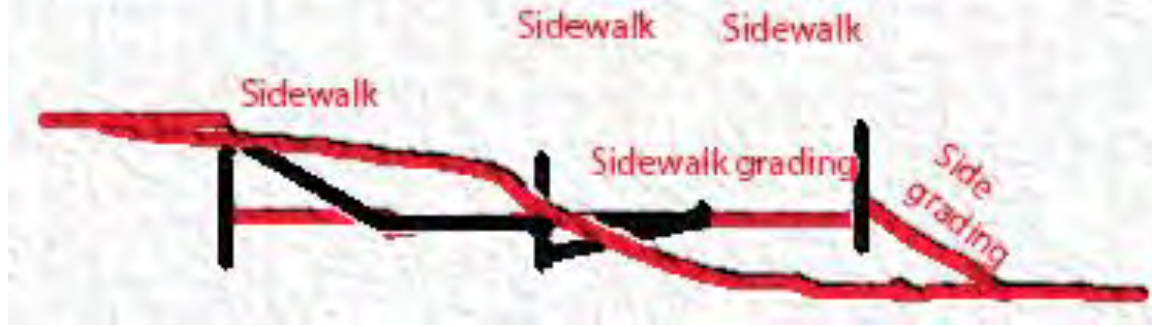
Fig. 19: Cross section in main roads, Egyptian rule No. 159 of 1998. (the